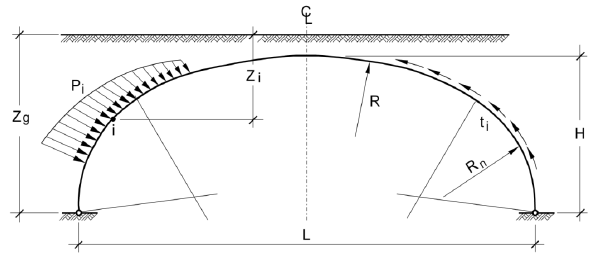
Figure 2: Model of soil-steel structure geometry and interactions.